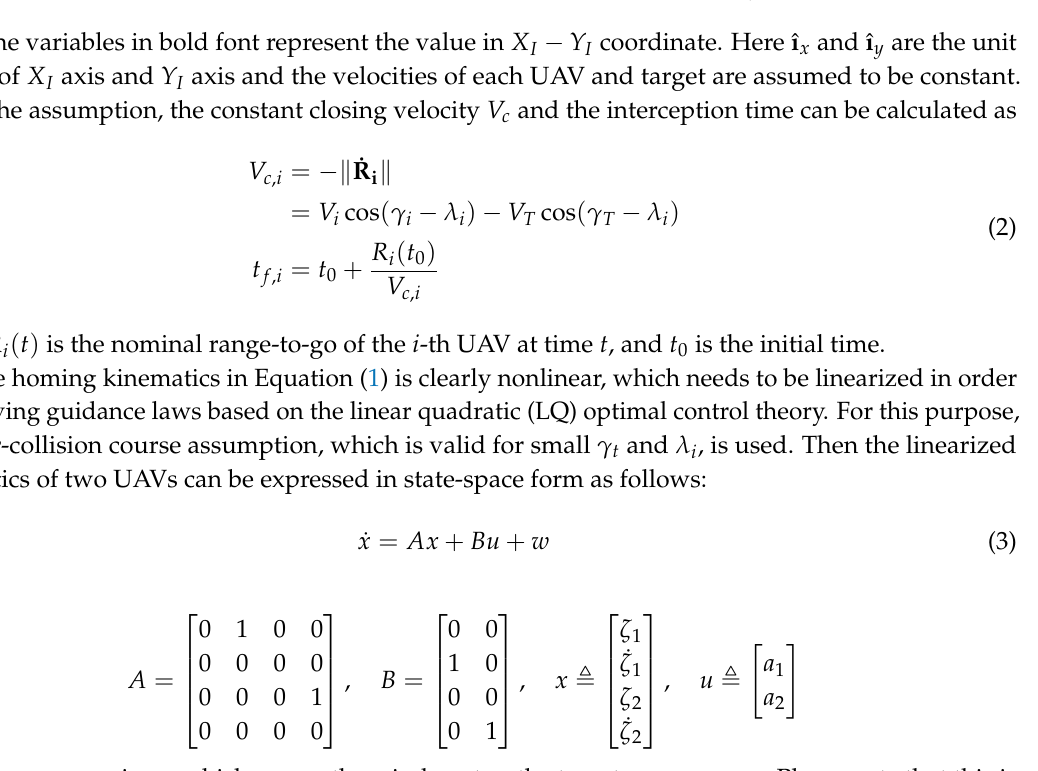
Figure 1. Two UAVs in cooperative engagement